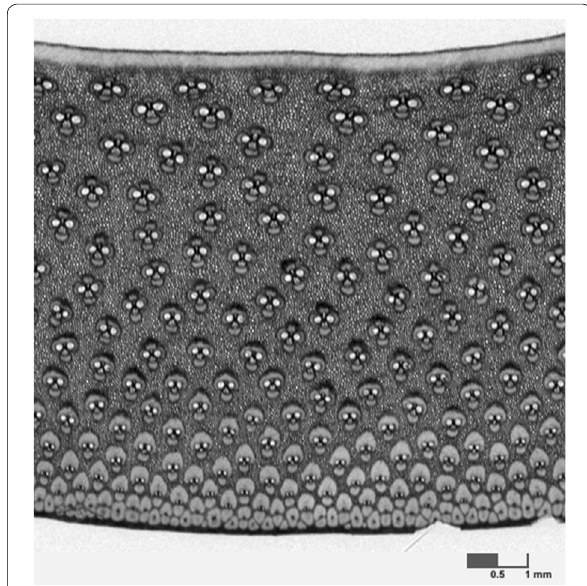
Fig. 7 X-ray phase-contrast microscopy image of a section of bamboo wall (moso)